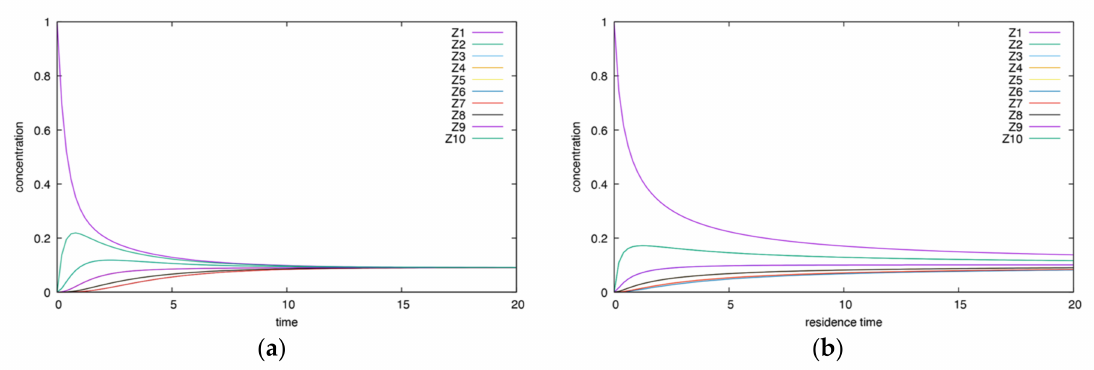
Figure A2. Evolutions in a BR ( a ) and in a CSTR ( b ) of the cyclic reversible mechanism, N = 10.